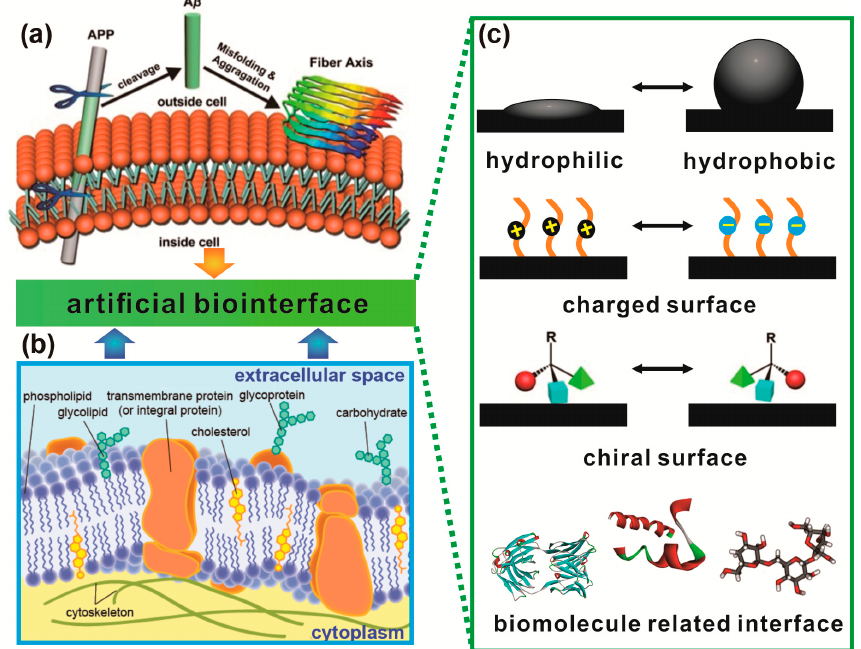
Figure 1. ( a ) Illustration of APP cleavage, A β misfolding and oligomer aggregation occurring on cell membranes [41]; ( b ) the cell membranes with complex components (i.e., carbohydrates, lipids, proteins, etc.), structures and various surroundings; and ( c ) several main types of artificial biointerfaces developed from different perspectives to investigate the effects of interfacial properties on protein aggregation. ( a ) Adapted with permission. Copyright 2014, American Chemical Society (ACS).